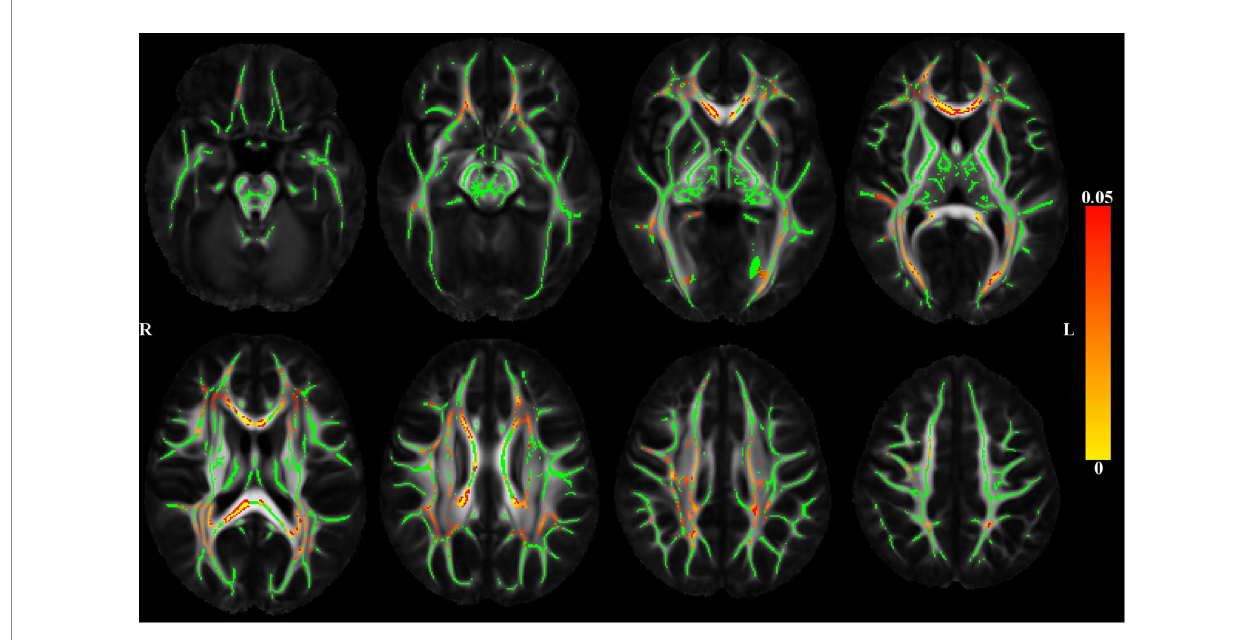
FIGURE 2 Maps of p values (warm color scale) showing voxels of the white matter skeleton (green color) with significant positive associations ( p < 0.05) between depressive symptoms and the trace of the diffusion tensor, in linear regression models adjusted for age, education, sex, scanner, total volume of WMHs normalized by intracranial volume and the presence of WMH at the voxel